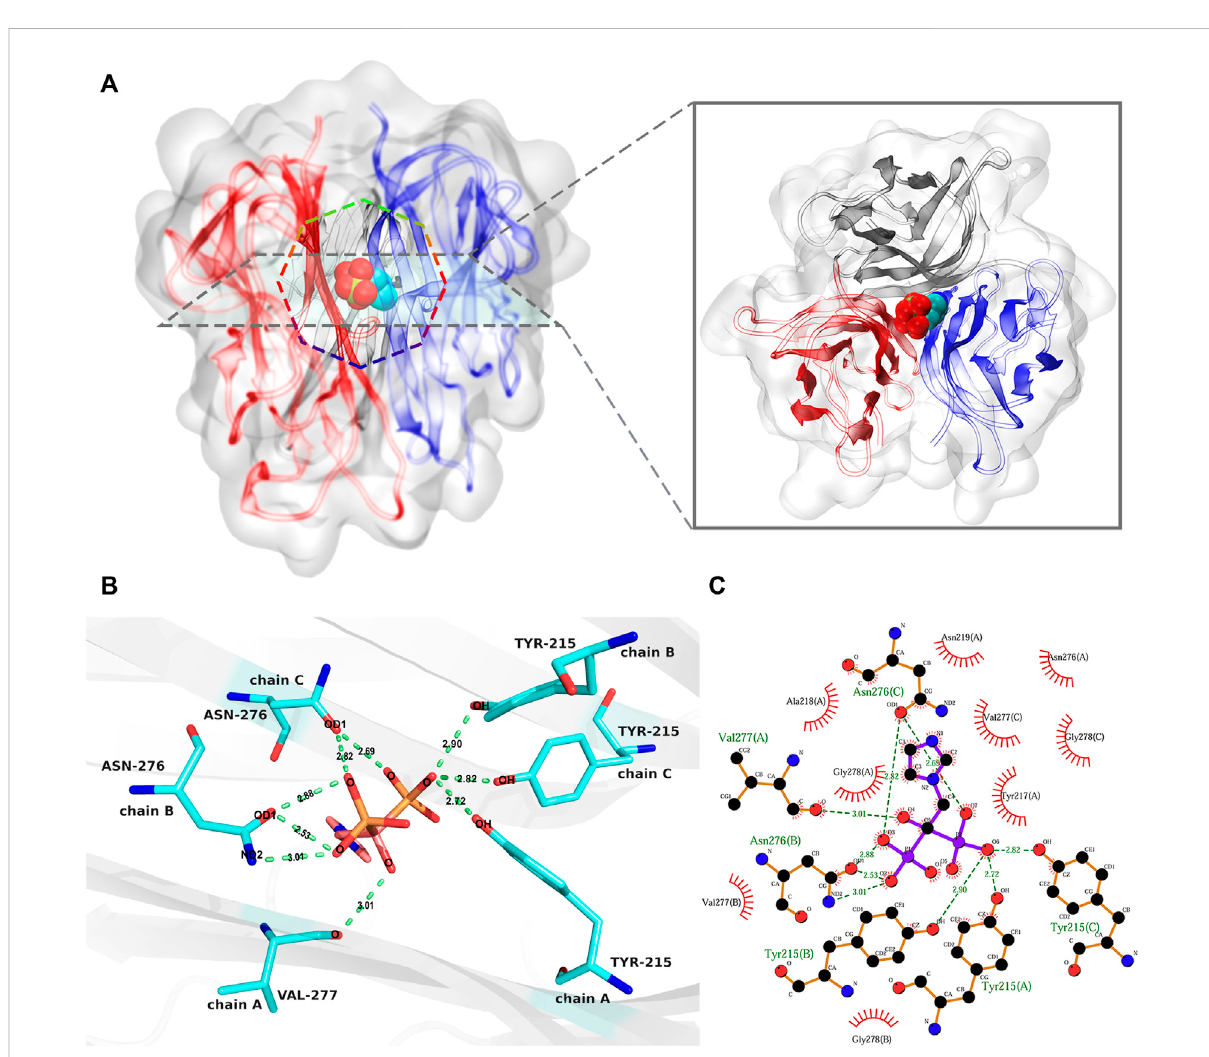
FIGURE 4 The analysis of the best binding pose of RANKL – ZOL complex. (A) shows the 3D conformation of the RANKL – ZOL complex from the front and vertical views, the structure of the RANKL trimer is shown as cartoon representation, and the structure of ZOL is shown as sphere representation. (B,C) depict the detailed interaction of RANKL and ZOL; (B) shows a 3D view of the hydrogen-bonding interactions between ZOL and RANKL; (C) showsthe2Dinteractionpro fi leofRANKL – ZOL,inwhichtheredlashesrepresenttheresiduesengagedinhydrophobicinteractions;thegreen dotted lines represent the hydrogen